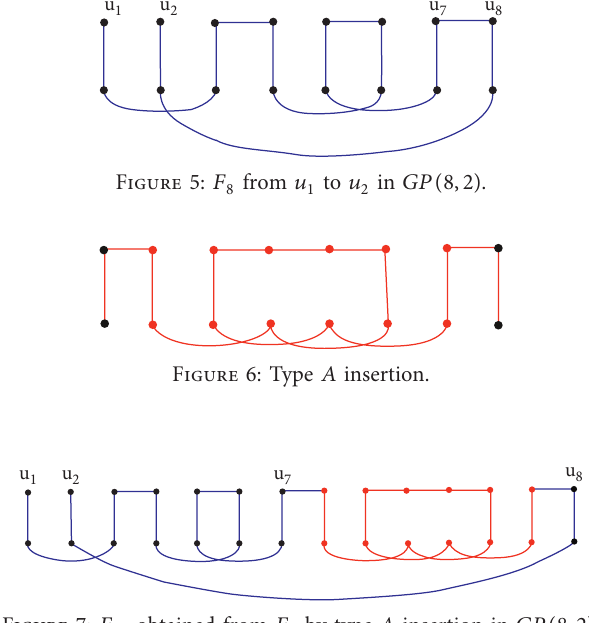
by type A insertion in GP ( 8 , 2 ) . 8